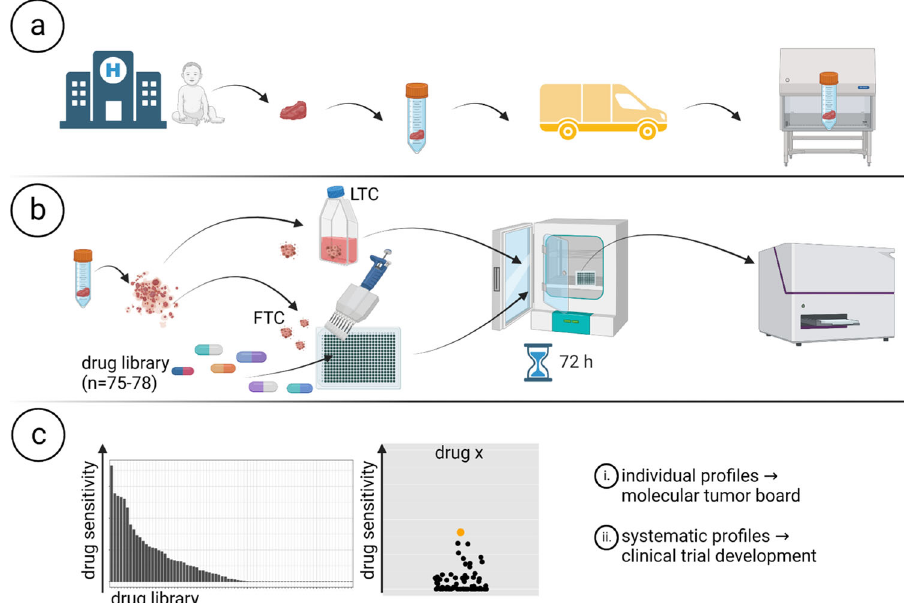
Fig. 1 Work fl ow of INFORM personalized drug sensitivity pro fi ling. Created with BioRender.com. a Sample collection and shipment. b Generation of patient-derived ex vivo fresh tissue spheroid cultures (FTCs) and treatment with a drug library. Readout: metabolic activity. c Data collection, analysis and preparation of drug sensitivity